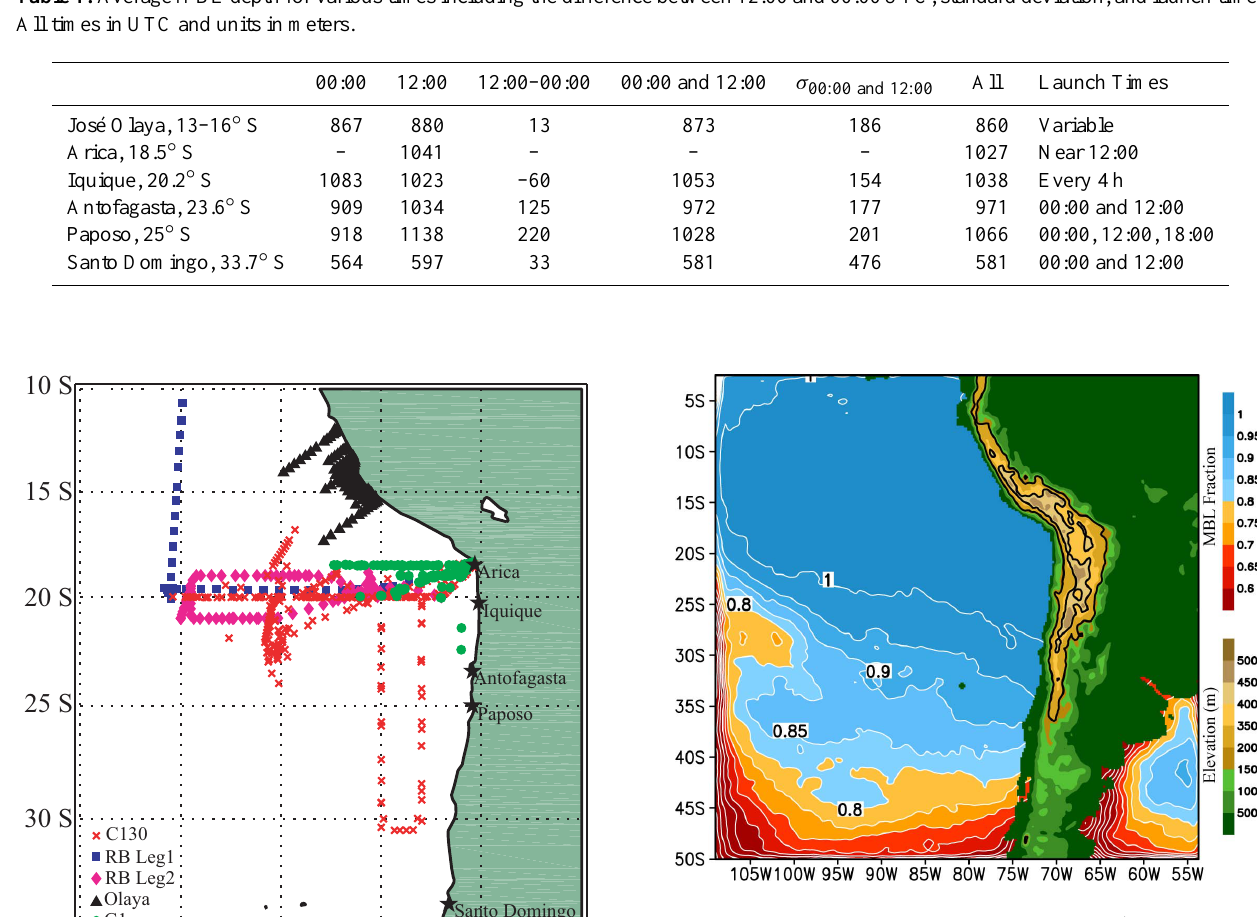
Fig. 2. WRF Domain showing terrain elevation (m, bottom color scale and black contours every 2000m) and fraction of time that a MBL was defined from WRF output (top color scale and white contours every